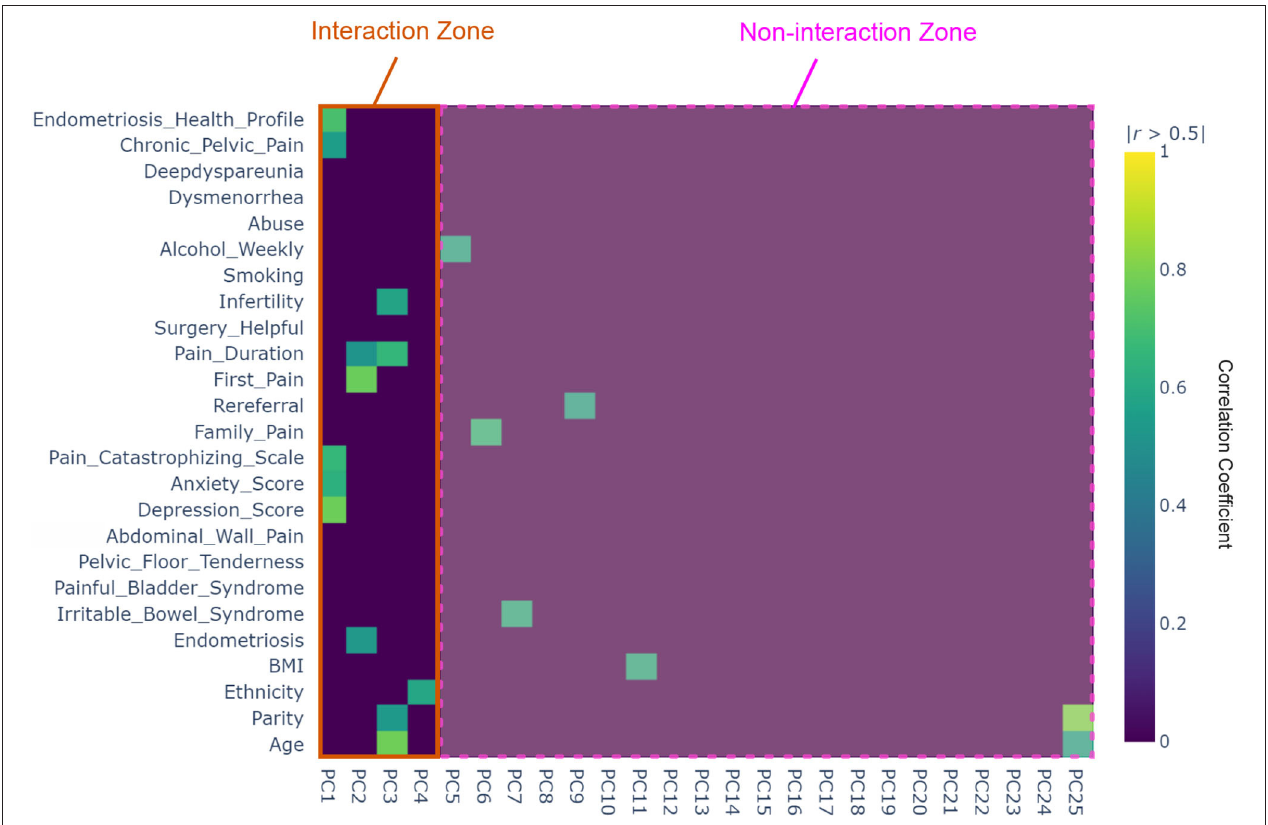
FIGURE 1 | Heat map of the interaction principle component analysis (IPCA) based on the determined 25 factors from the Pelvic Pain and Endometriosis database. The interaction zone refers to the number of principle components (PCs) where two or more factors are correlated, while the non-interaction zone refers to the number of PCs that have only single factor that is not correlated with any other